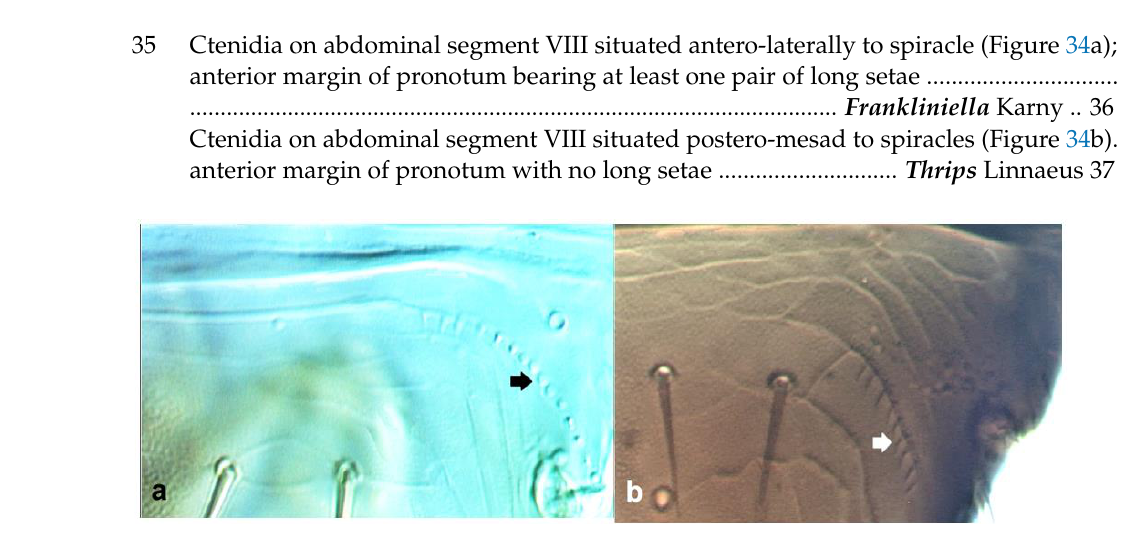
Figure 34. Position of ctenidia on abdominal segment VIII: ( a ) antero-laterally to spiracle; ( b ) postero-mesad to spiracles. 36 Ocellar setae iii arising on anterior margins of ocellar triangle (Figure 35a); meta- thoracic campaniform sensilla present (Figure 35e); microtrichial comb at the pos- terior margin of tergite VIII fully developed (Figure 35d) .............................................. Ocellar setae iii arising close together between hind ocelli (Figure 35b); meta-thoracic campaniform sensilla absent (Figure 35d); microtrichial comb at the posterior margin of tergite VIII not developed or with few short teeth on lateral margins (Figure 35f)